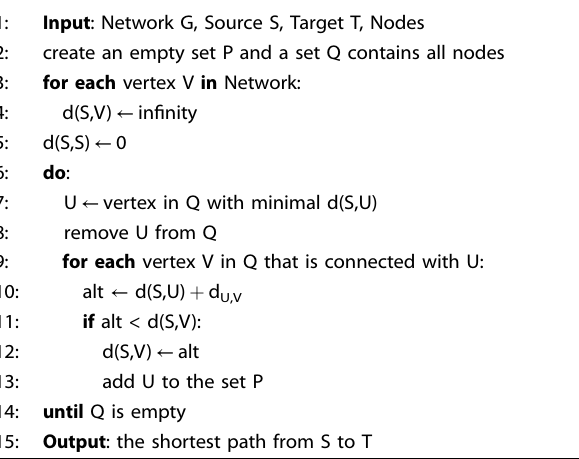
algorithm, module detection algorithm, and node prioritization methods using node centrality in identifying cancer therapeutic targets and discovering drugs.